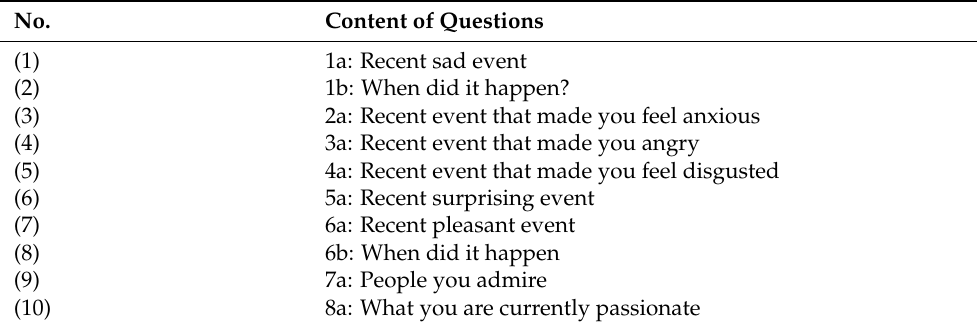
Table 1. 10 items asked in the episode description task in the